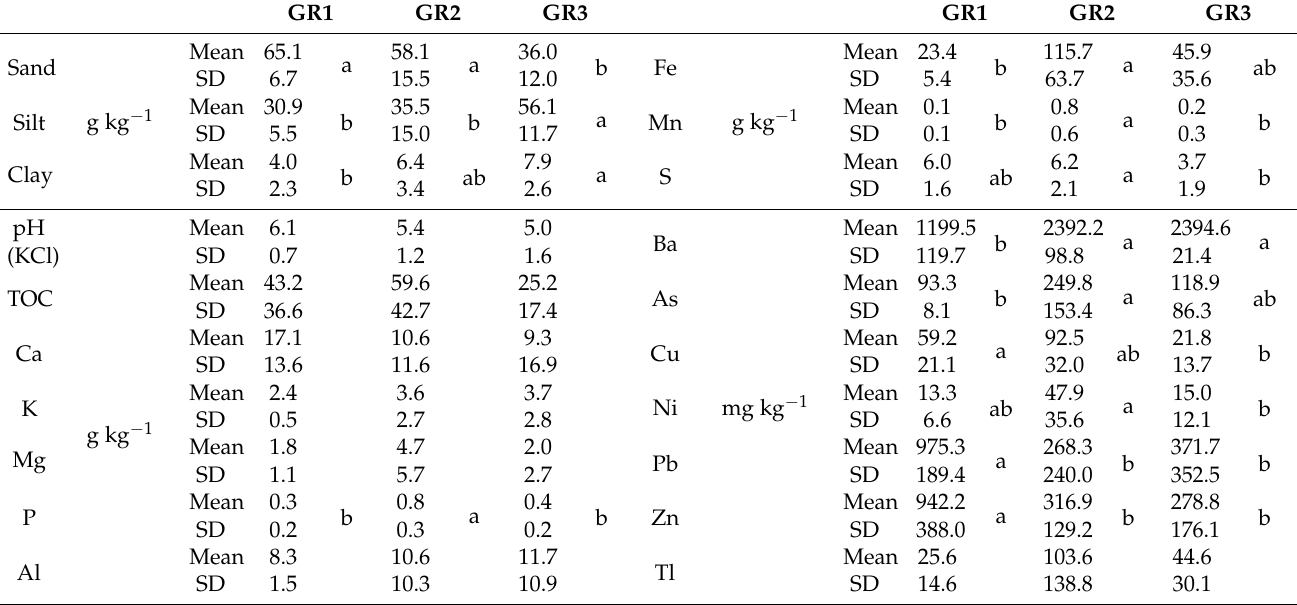
Table 3. Physicochemical characteristics’ mean and standard deviation (SD) of soil samples collected from the different soil profile (mean value of A and AC horizons) of soil profiles in mining rocks deposits (GR1), soils formed on coarse debris of mining landfill or on altering mine debris (GR2), soils formed on mining flotation deposits (GR3). Different letters within the row (a, ab and b) indicate significant differences among the values ( p < 00.5).